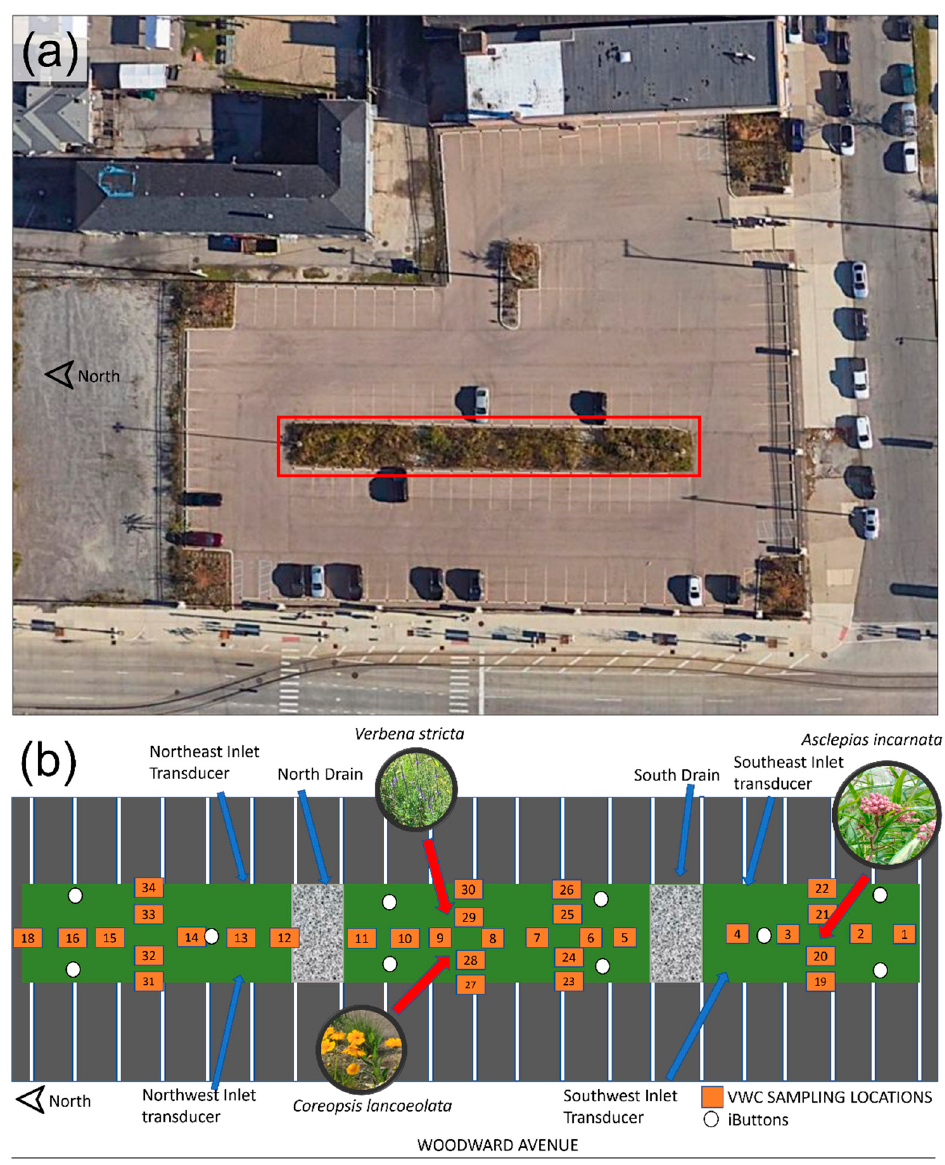
Figure 3. Description of the bioswale site with ( a ) an aerial photograph of Wayne State University’s Parking Lot 12 (with the bioswale outlined in a red rectangle) and ( b ) field survey plots of soil moisture, air temperature, surface water stage and temperature, and stomatal conductance. The aerial